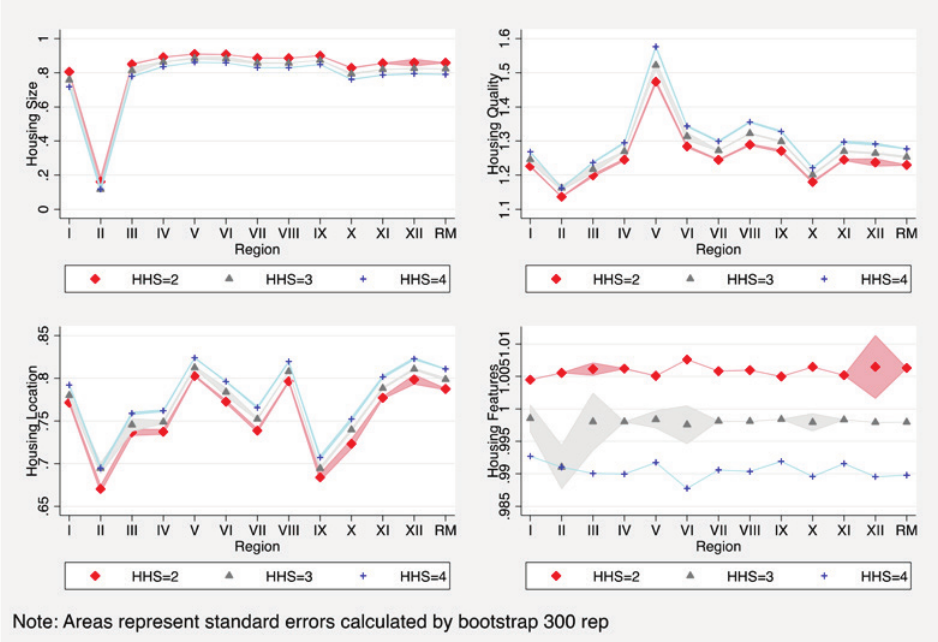
Figure 2. Regional income elasticities for housing